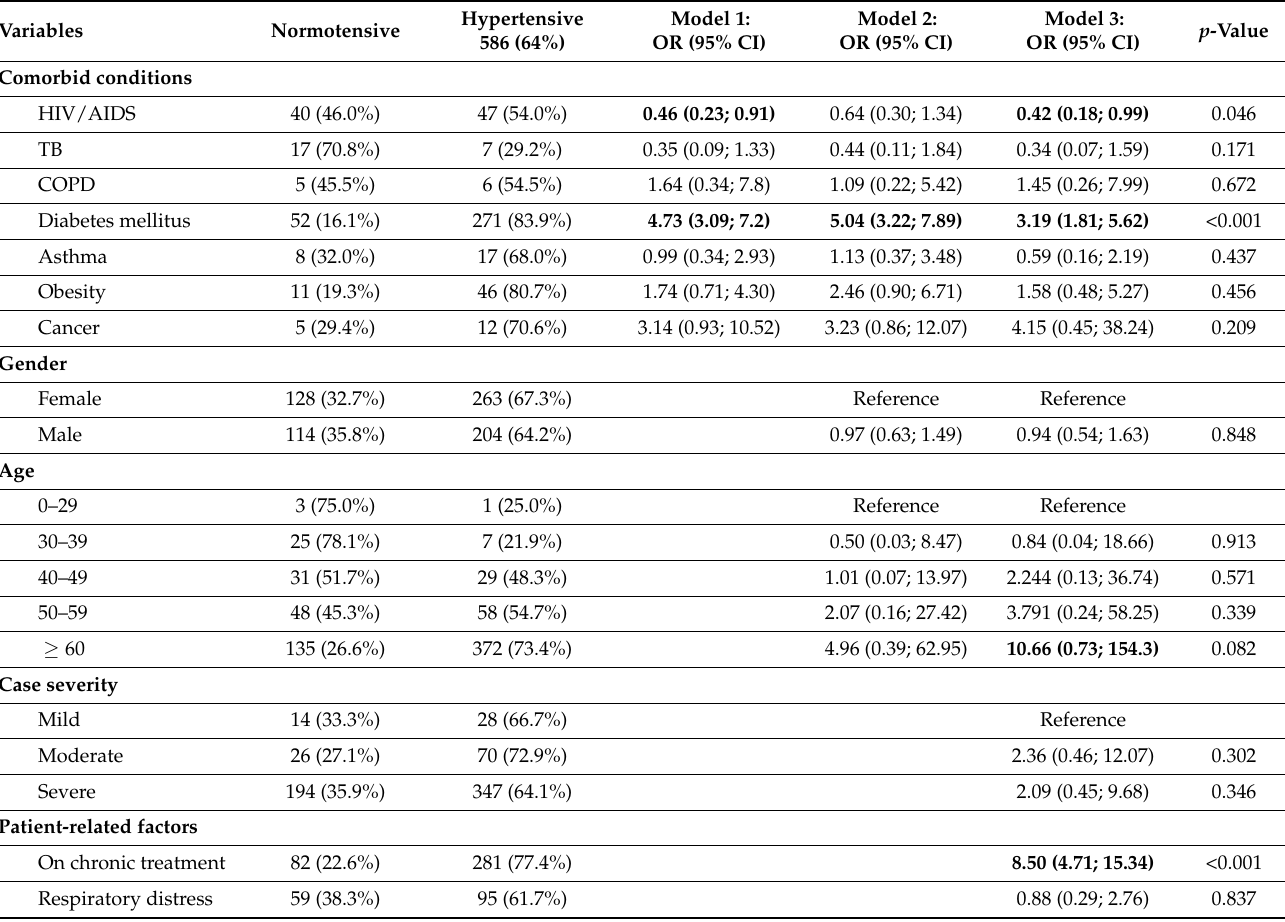
Table 2. Prevalence of hypertension of all the patients admitted with COVID-19 in Limpopo